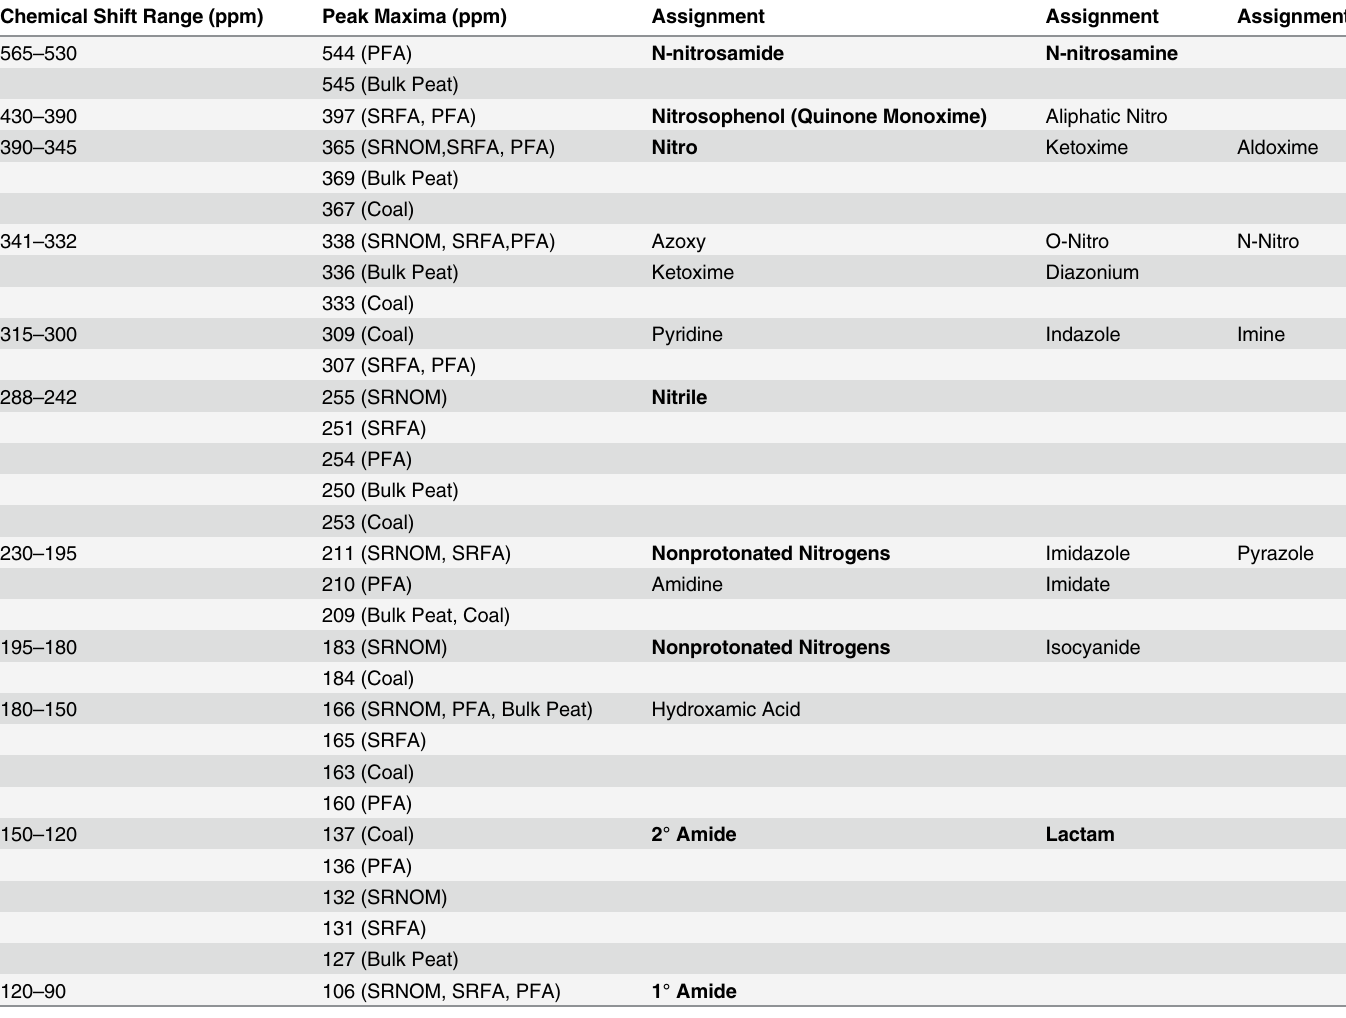
Table 3. Assignments for N-15 NMR spectra of NOM samples treated with nitric acid a . Chemical Shift Range